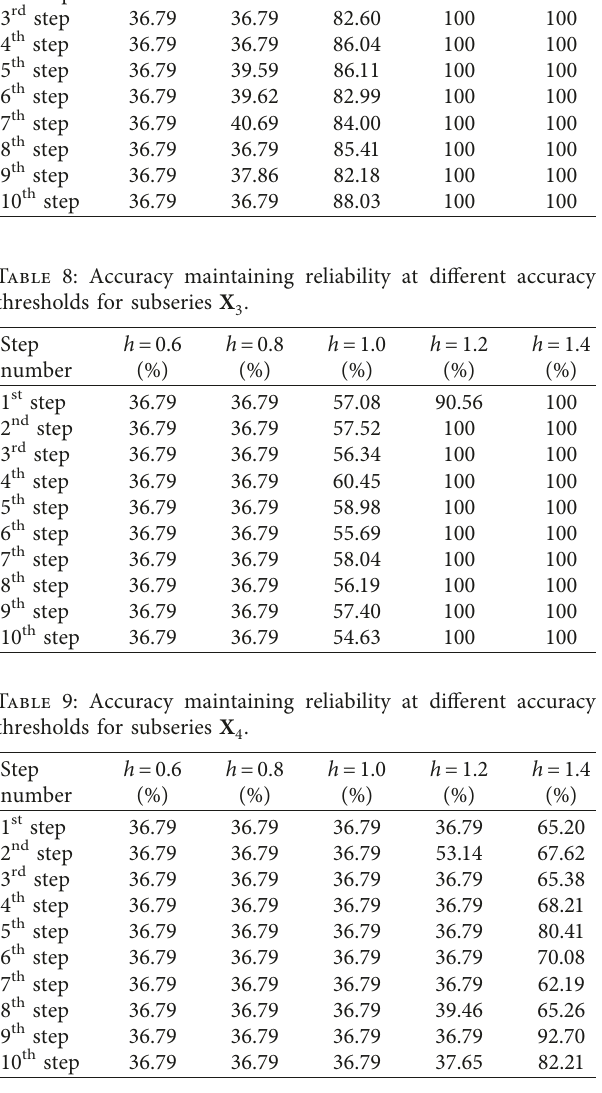
Table 7: Accuracy maintaining reliability at different accuracy thresholds for subseries X